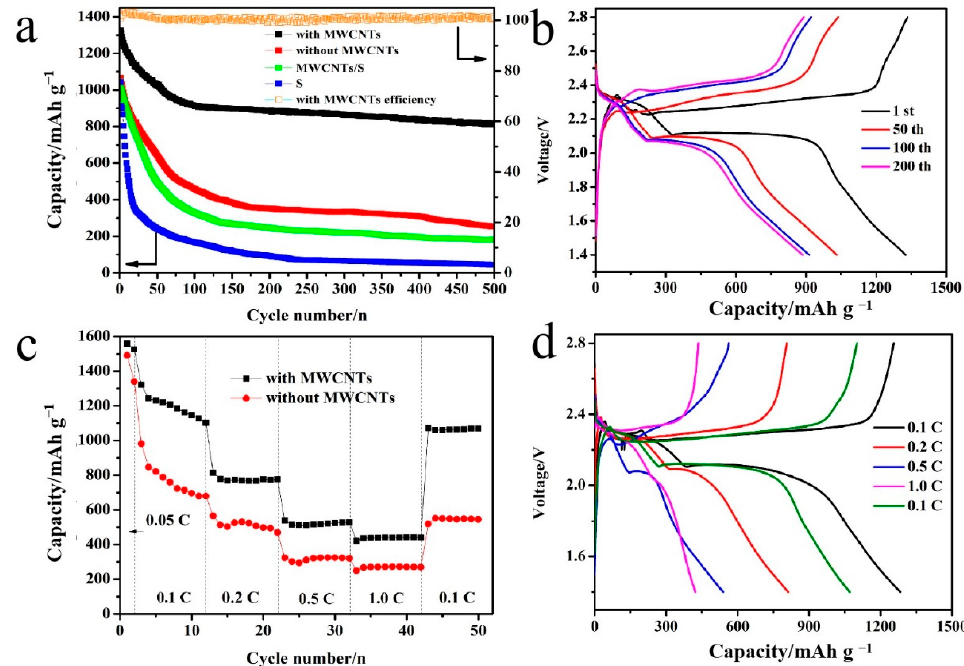
Figure 6. ( a ) Long-term cycle, ( b ) galvanostatic discharge–charge voltage profiles for MWCNTs batteries, ( c ) rate performance graph of Li-S batteries, ( d ) galvanostatic discharge–charge voltage profiles for MWCNTs batteries at different rates.